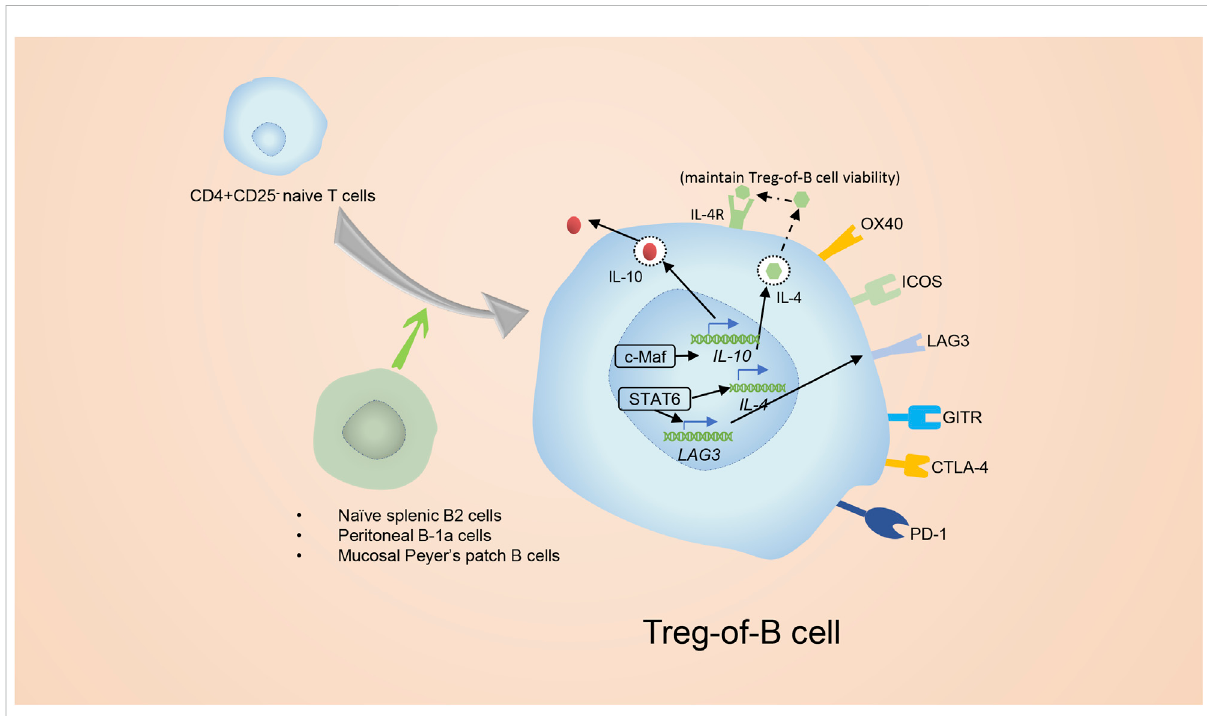
FIGURE 6 The introduction of Treg-of-B cells. Splenic B2 cells and mucosal Peyer ’ s patch B cells as well as peritoneal B-1a cells are able to promote the conversion of CD4 + CD25 − T cells to CD4 + Foxp3 - Tregs. The CD4 + Foxp3 - Tregs are known as Treg-of- B cells. Treg-of- B cells express molecules similar to conventional Tregs, for example ICOS, LAG3, GITR and OX40. In addition, Treg-of- B cells express CTLA4 and PD-1 as well, but do not express Foxp3. Activation of STAT6 was essential for the development of Treg-of-B cells. Phosphorylated STAT6 elevates the expression of LAG3, which is involved in generating and maintaining the function of Treg-of-B cells. After culture with B cells, Treg-of-B cells elevate their level of c-Maf which regulates expression of IL-10, ICOS, and